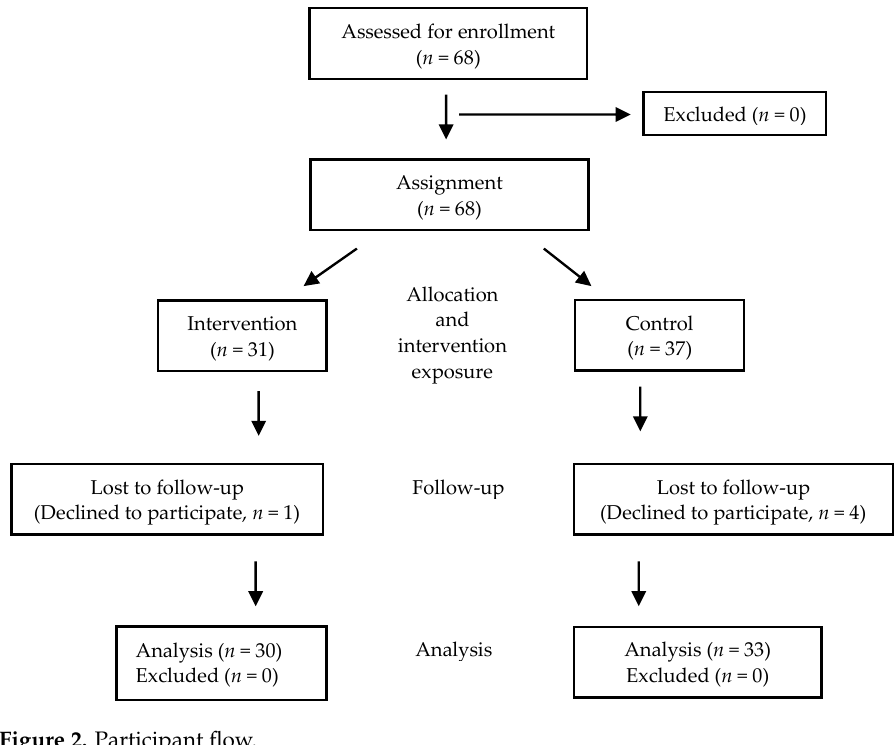
Figure 2. Participant flow.